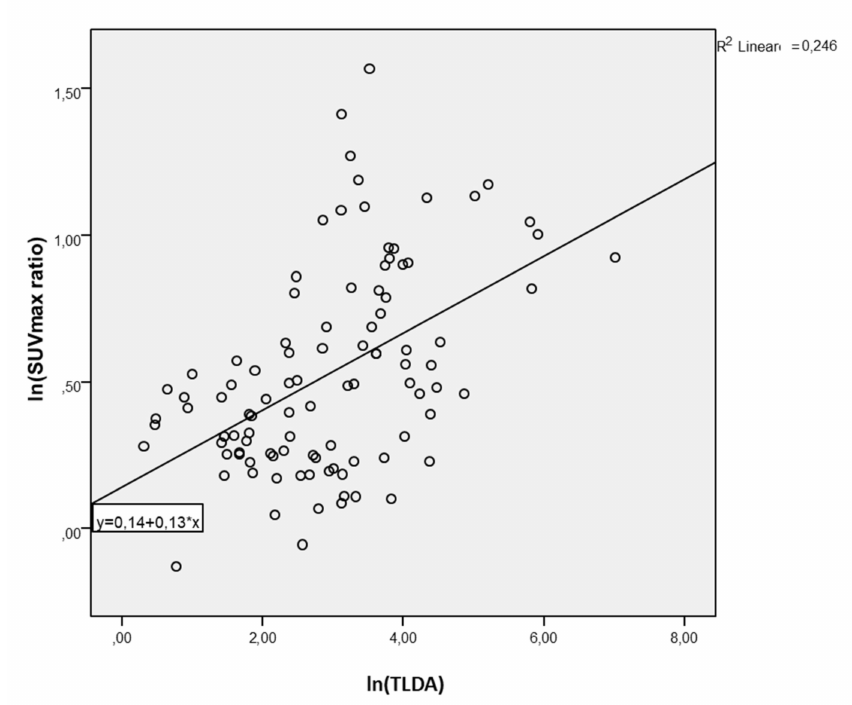
Figure 5. Univariate analysis model of the association between lnSUVmax ratio and